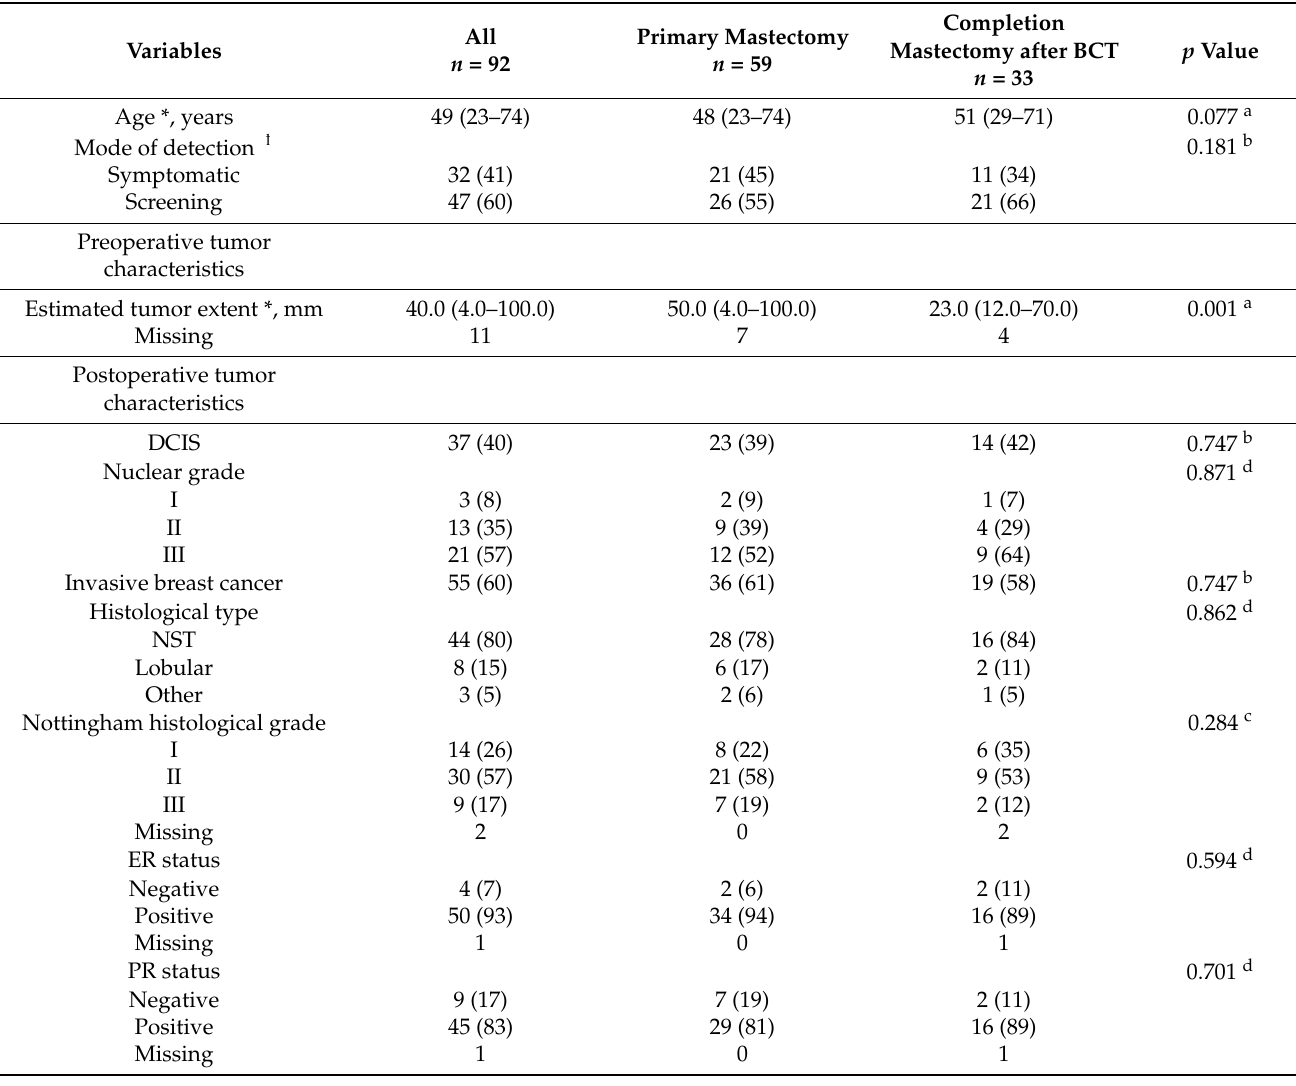
Table 1. Patient and tumor characteristics in the overall study cohort.